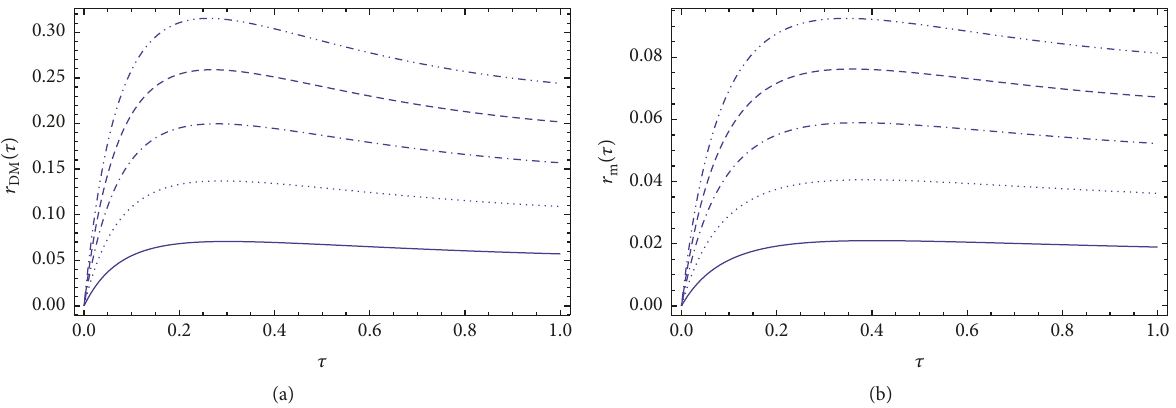
Figure 3: Time variation of the dark matter energy density (a) and of the radiation (b) during the reheating period in the presence of a small-field power law potential, for different values 𝛼 𝜙 of the decay width of the scalar field: 𝛼 𝜙 = 0.15 (solid curve), 𝛼 𝜙 = 0.30 (dotted curve), 𝛼 = 0.45 (dash dotted curve), 𝛼 = 0.60 (dashed curve), and 𝛼 = 0.75 (dash double dotted curve), respectively. For 𝑝 we have adopted the 𝜙 𝜙 𝜙 value 𝑝 = 3 , while 𝜇 = 10 3 . The initial conditions used to numerically integrate (99) are 𝜙(0) = 1 , 𝑢(0) = −4 , 𝑁 𝜙 (0) = 5 , 𝑟 DM (0) = 0 , and 𝑟 (0) = 0 , m